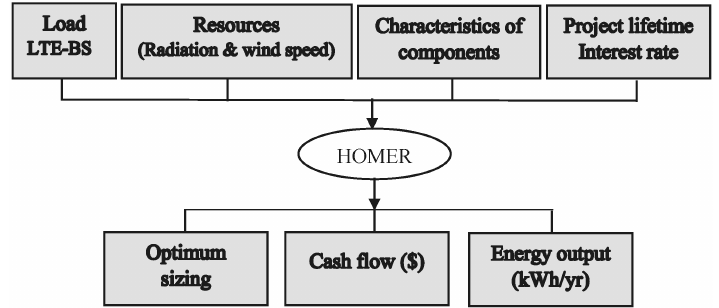
Figure 5. Architecture of HOMER software.